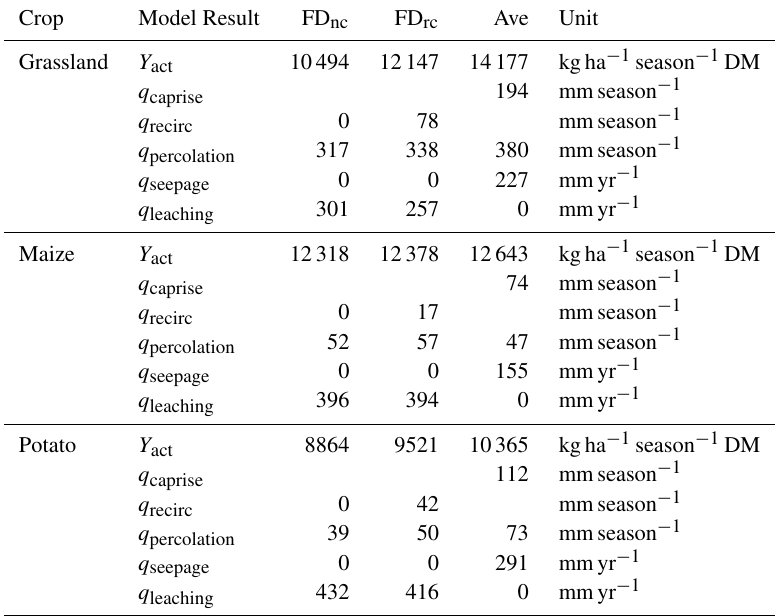
Table 4. Results of soil crop experiments: mean values of six model results from three different hydrological conditions: FDnc (free drainage with no recirculation), FDrc (free drainage with recirculation) and Ave (average drainage